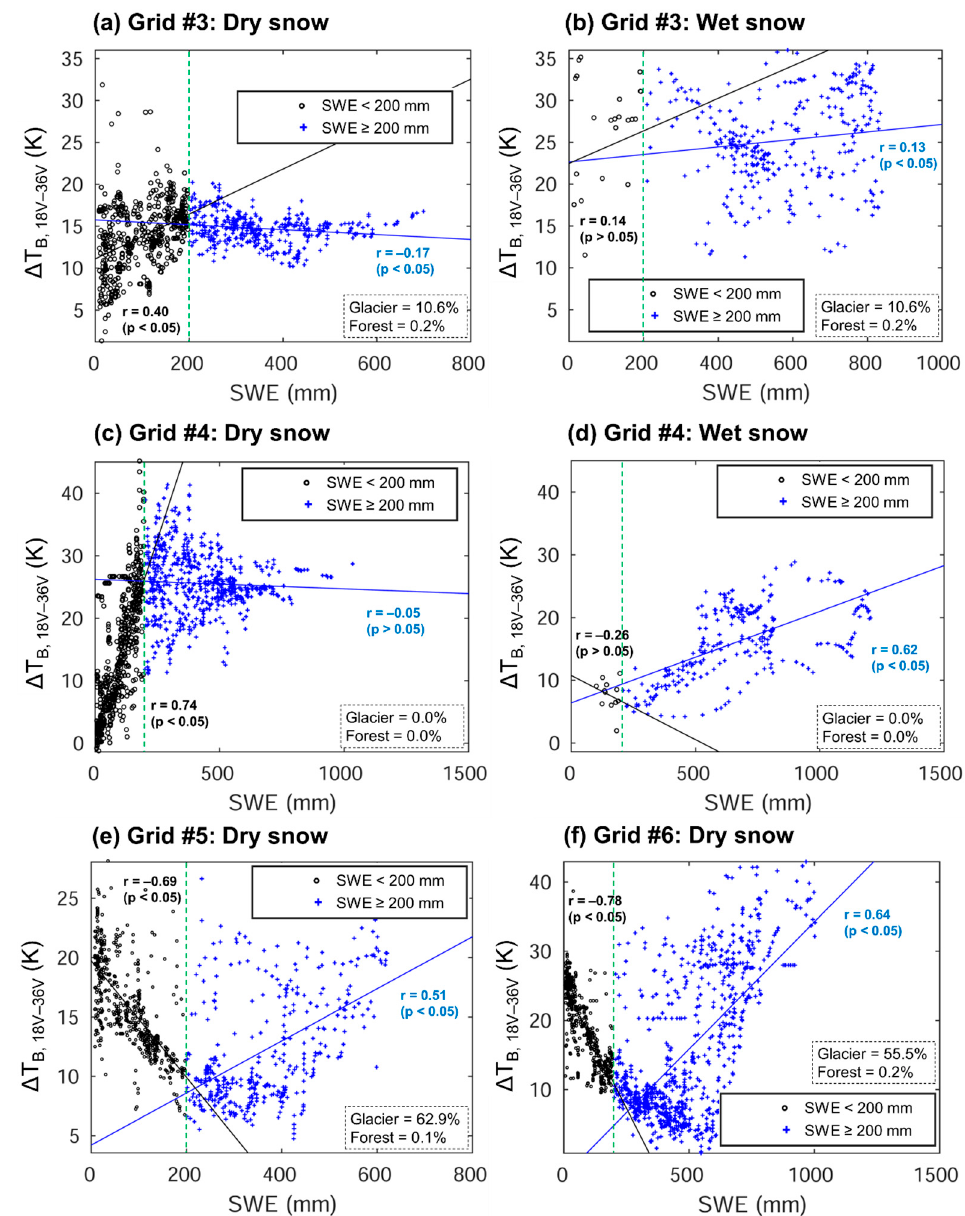
Figure 4. Correlations between the Noah-MP simulated SWE and SVM-based Brightness temperature spectral difference ( Δ T B) 18 V–36 V estimates for Grid #3 ( a : dry snow, b : wet snow), Grid #4 ( c : dry snow, d : wet snow), and glaciated regions ( e , f ) marked in Figure 2. A SWE threshold of 200 mm was used for the slope reversal associated with signal saturation.